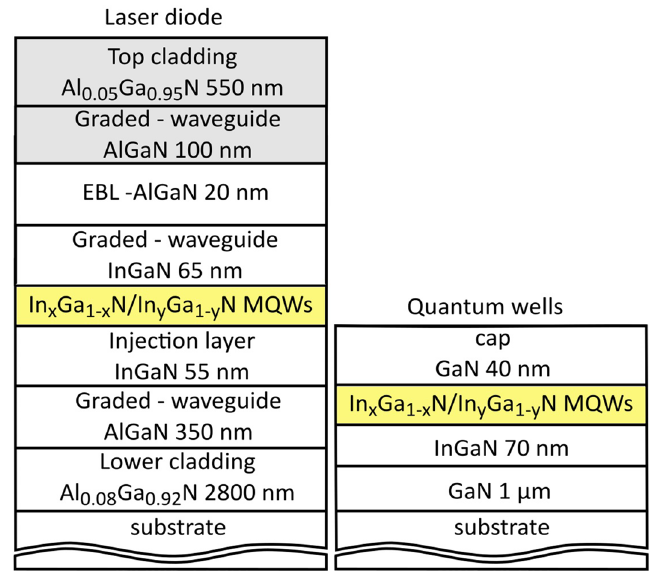
Figure 1. Simplified schemes of investigated epitaxial